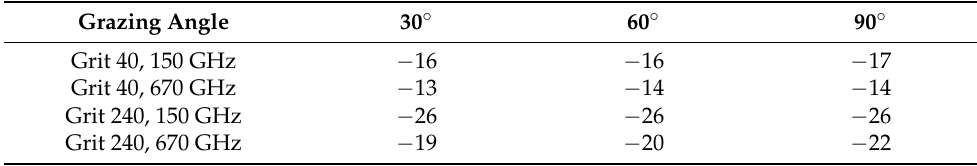
Table 4. Cross-polarized backscatter ratio q , dB. Grazing